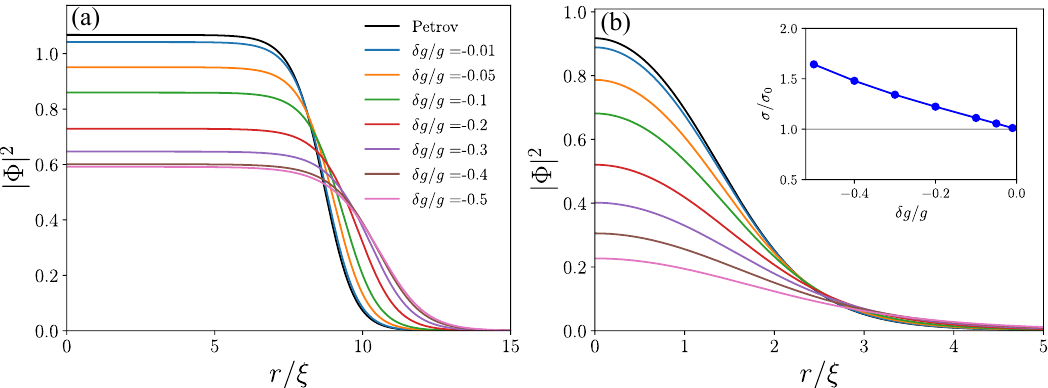
Figure 5: Density profile of the self-bound droplet obtained from the GPE (16) for ξ 3 = 3000 (b) = 30. The upper black line is the universal result of Petrov’s (a) N / n 0 theory [ 3 ] , whereas the color lines are results from our beyond-LHY approach, cal- culated for different values of interaction strength. Color guides are the same for the upper and lower panel and are ordered in increasing the disbalance δ g / g from top to bottom. The inset in the lower panel reports the mean-square size of the droplet, normalized to the value σ coming from Petrov’s theory, as a function of δ g / g 0